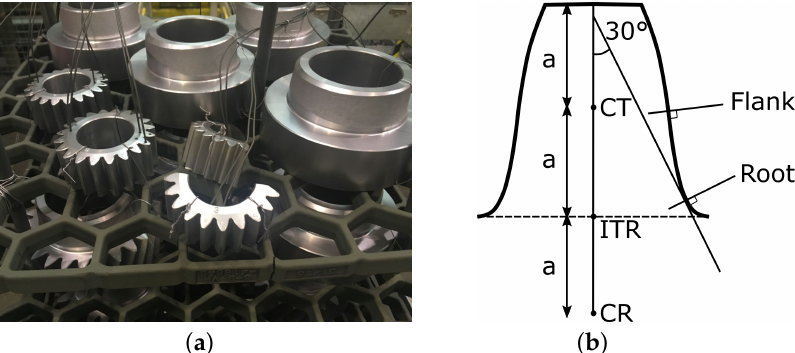
Figure 1. ( a ) Setup for temperature measurement during cooling with a data logger with 16 type N TCs in full and half gears at different positions as well as Inconel probes. The data logger is positioned towards the back of the image ( b ) Schematic of a gear tooth with positions marked at center of tooth (CT), interface of gear tooth and ring (ITR) and center of gear ring (CR) as well as gear flank and root. TCs were positioned in holes drilled at CT and